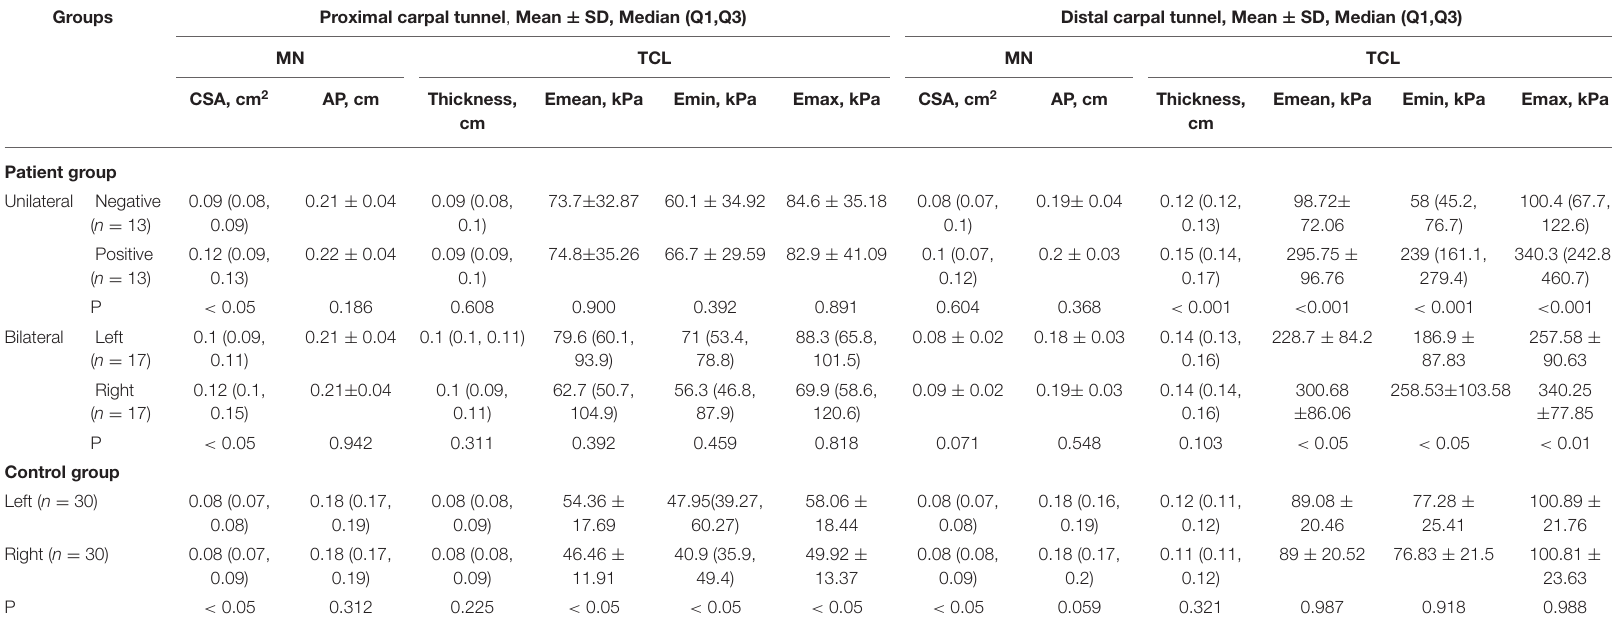
TABLE 2 | The MN (CSA and AP) and TCL (thickness and stiffness) measurements in the patient group with unilateral and bilateral positive hands, and the control group. Groups Proximal carpal tunnel , Mean ± SD, Median